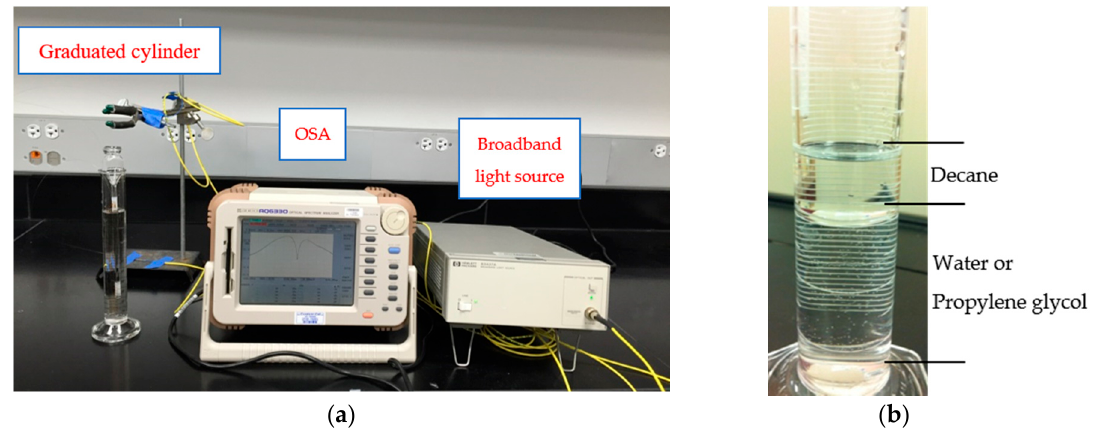
Figure 3. ( a ) Experimental setup; ( b ) Photo for the layered liquids.